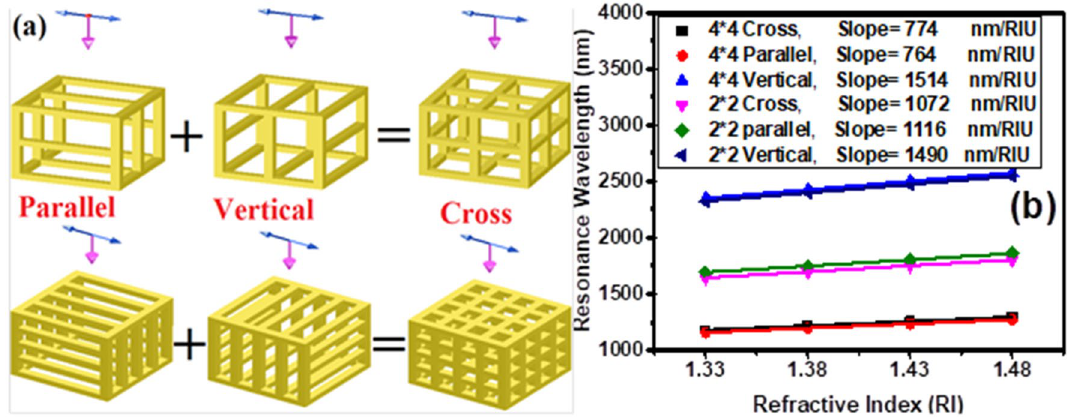
Figure 5. ( a ) Schematic views of divided nanocages into two structures of vertical and parallel, which have walls perpendicular and parallel to the direction of incident light polarization, respectively. ( b ) Resonance wavelength shift of 2*2 and 4*4 nanocages and their divided structures, vertical and parallel, versus different refractive index of surrounding medium. Browser-based version of SketchUp, https ://app.sketc hup.com, and Origin 2020 version, https ://www.origi nlab.com, have been used for drawing images and making figures, respectively.